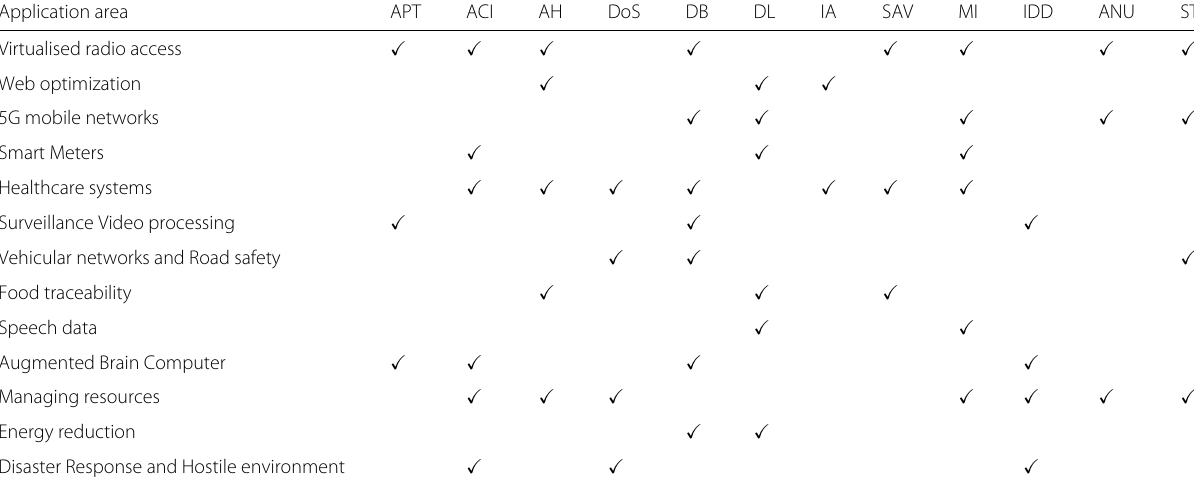
Table 1 Knowledge gaps for application area based analysing current Fog implementations against the twelve categories of security